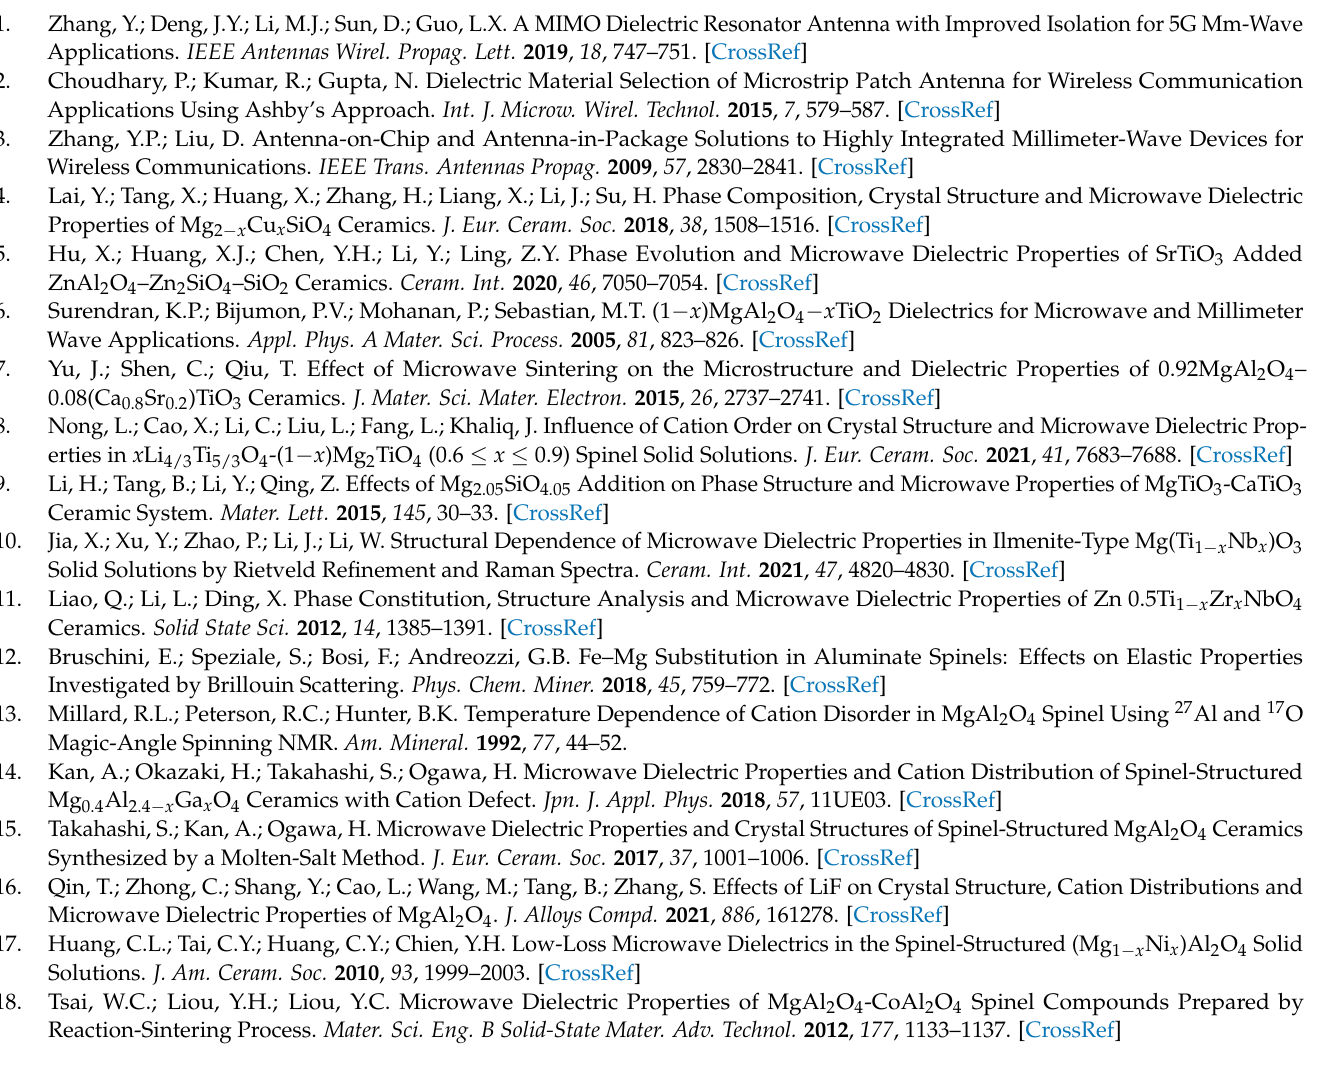
Table S3: Lattice energy U cal (kJ mol − 1 ) for Mg 1 − x Cu x Al 2 O 4 ceramics sintered at 1550 ◦ C;. Table